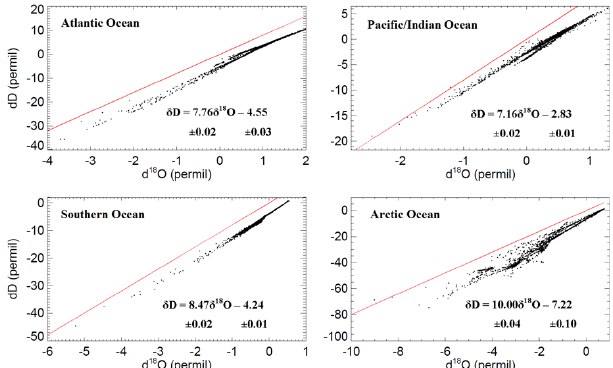
Fig. 7. Relationship between deuterium and oxygen-18 of surface waters in different ocean basins obtained by our model. The red line in each panel represents the linear approximation δ D = 8* δ 18